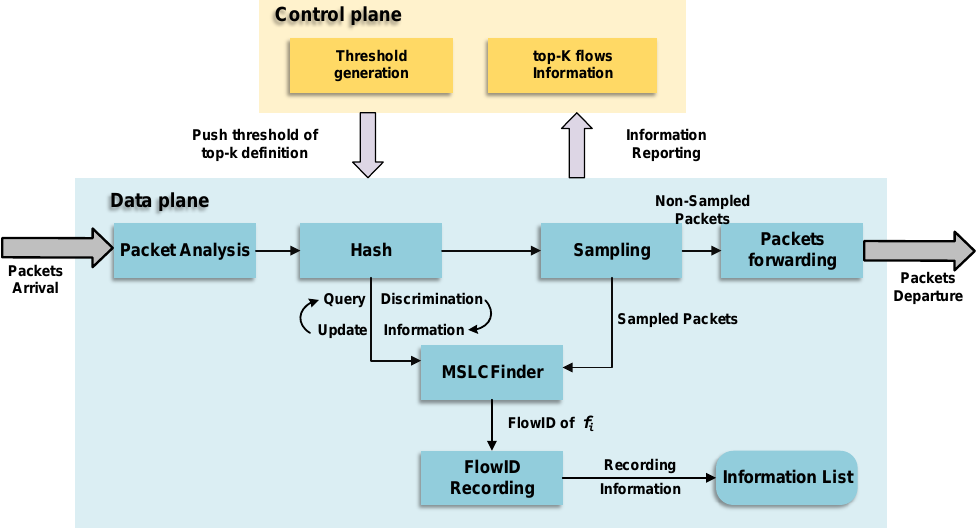
Figure 4. The scheme overview of top- k flows measurement task in networks based on